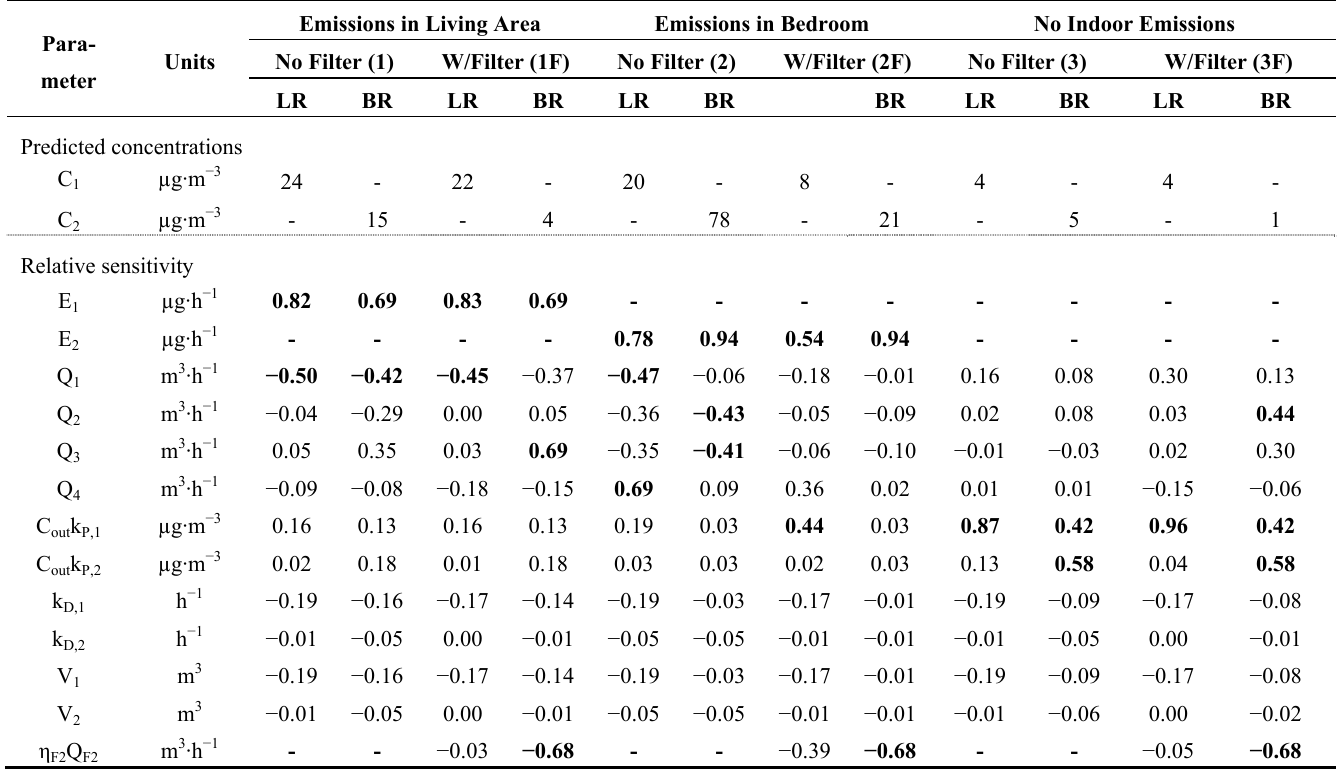
Table 6. Relative sensitivity of model parameters on predicted concentrations in living area (LR) and bedroom (BR) for six scenarios (scenario number in parentheses). Absolute values greater than 0.40 are shown in